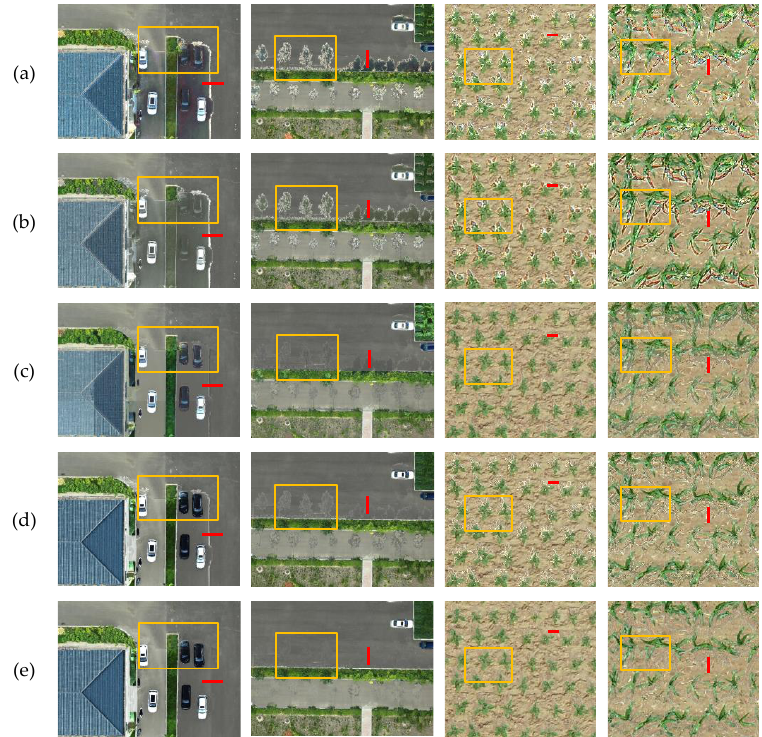
Figure 8. The compensation results of different methods applied to the four study regions: (a) Silva’s method; (b) Gilberto ’ s method; (c) Liu ’ s method; (d) the proposed method (without penumbra compensation); (e) the proposed method (with penumbra compensation).